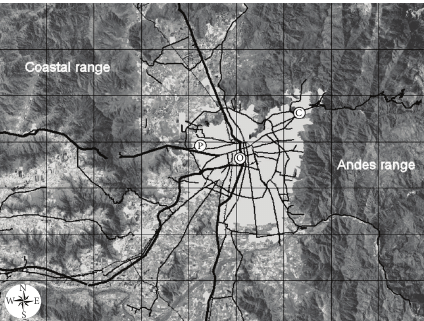
Figure 1: Regional topography of Santiago Metropolitan Area (SMA), Chile (with 10km grid lines). The gray area is the urban region, and the black lines represent the main routes and streets. White dots designate the three air quality monitoring stations of the MACAM-2 network that were used in this study (C: Las Condes, O: Parque O’Higgins, and P: